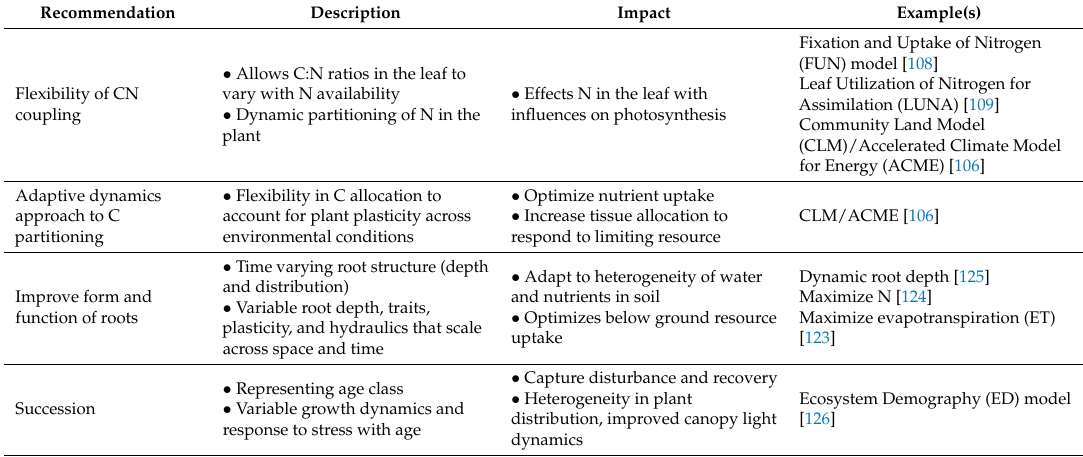
Table 2. Summary of recommendations for model